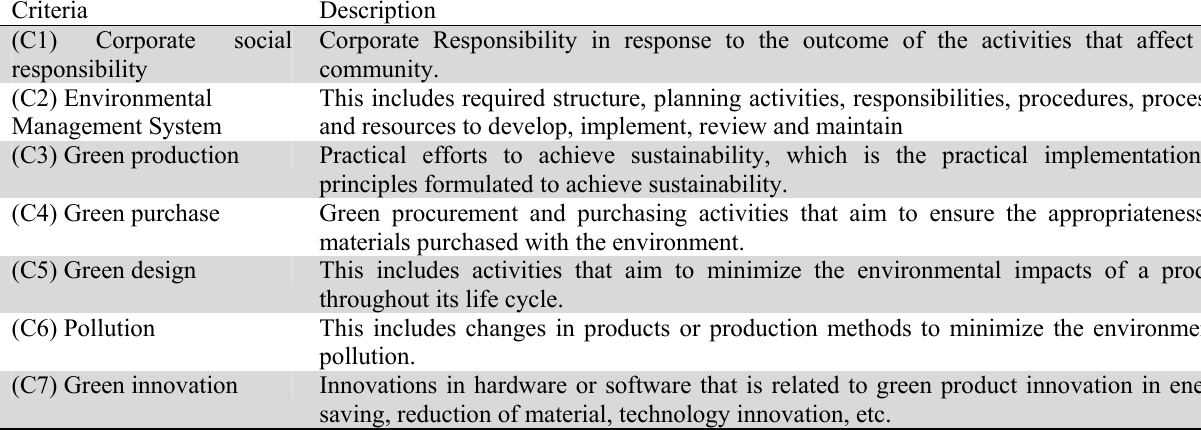
Description of the criteria associated with green supply chain Criteria